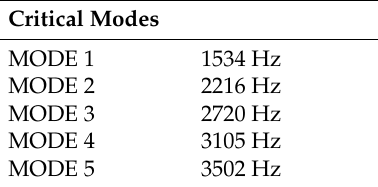
Table 1. Critical